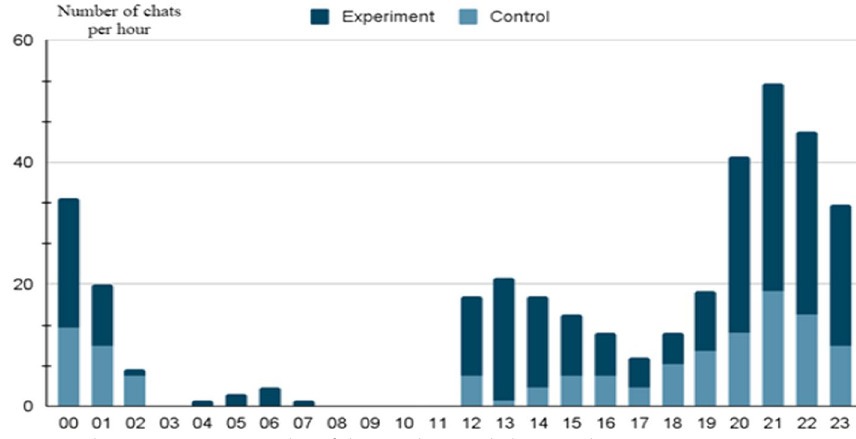
Fig. 3 Students’ engagement (number of chats per hour) with the KNUSTbot